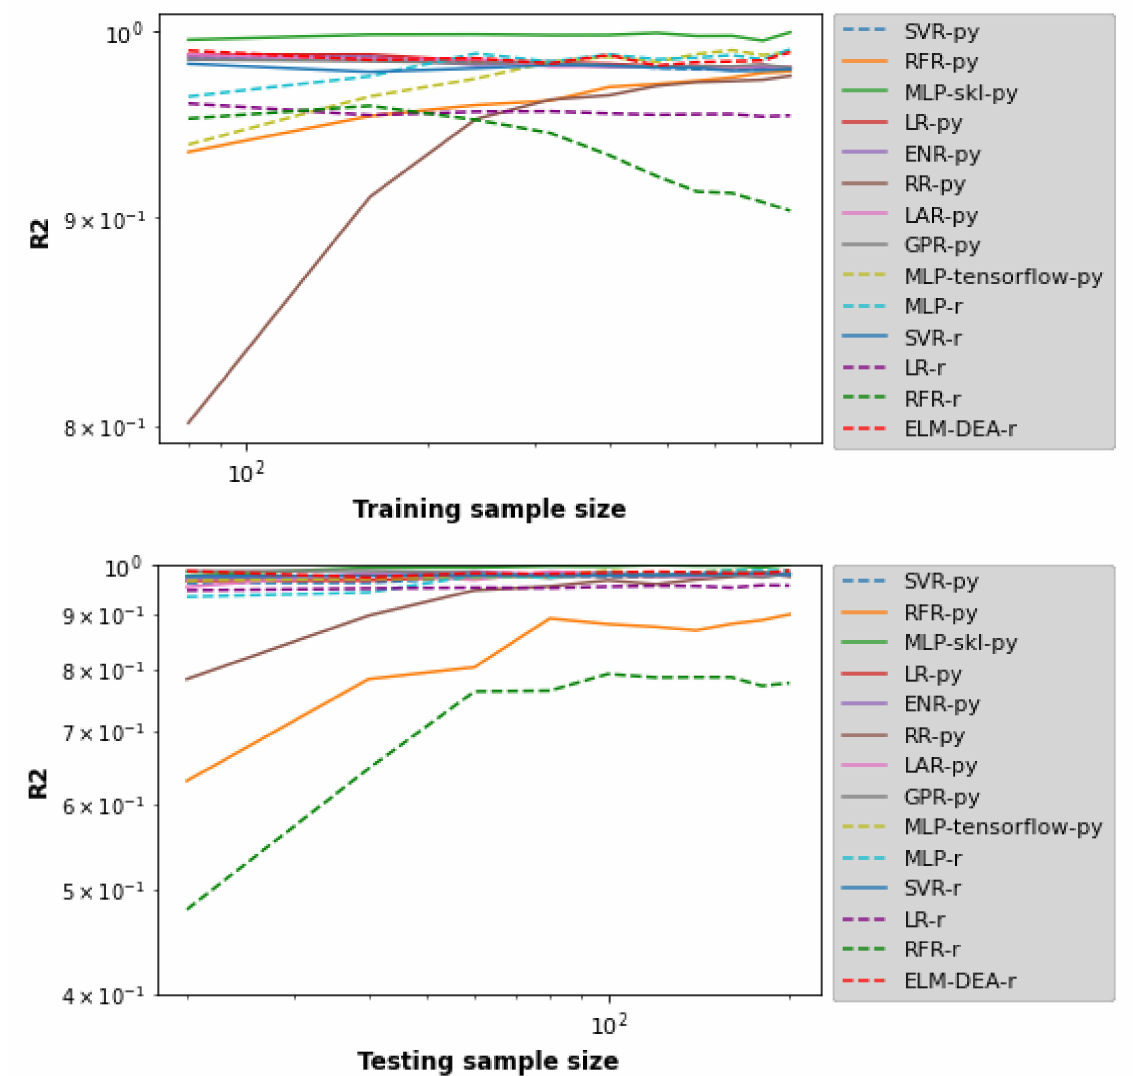
Figure 3. Performance of SML tools to construct SMs for grinding model